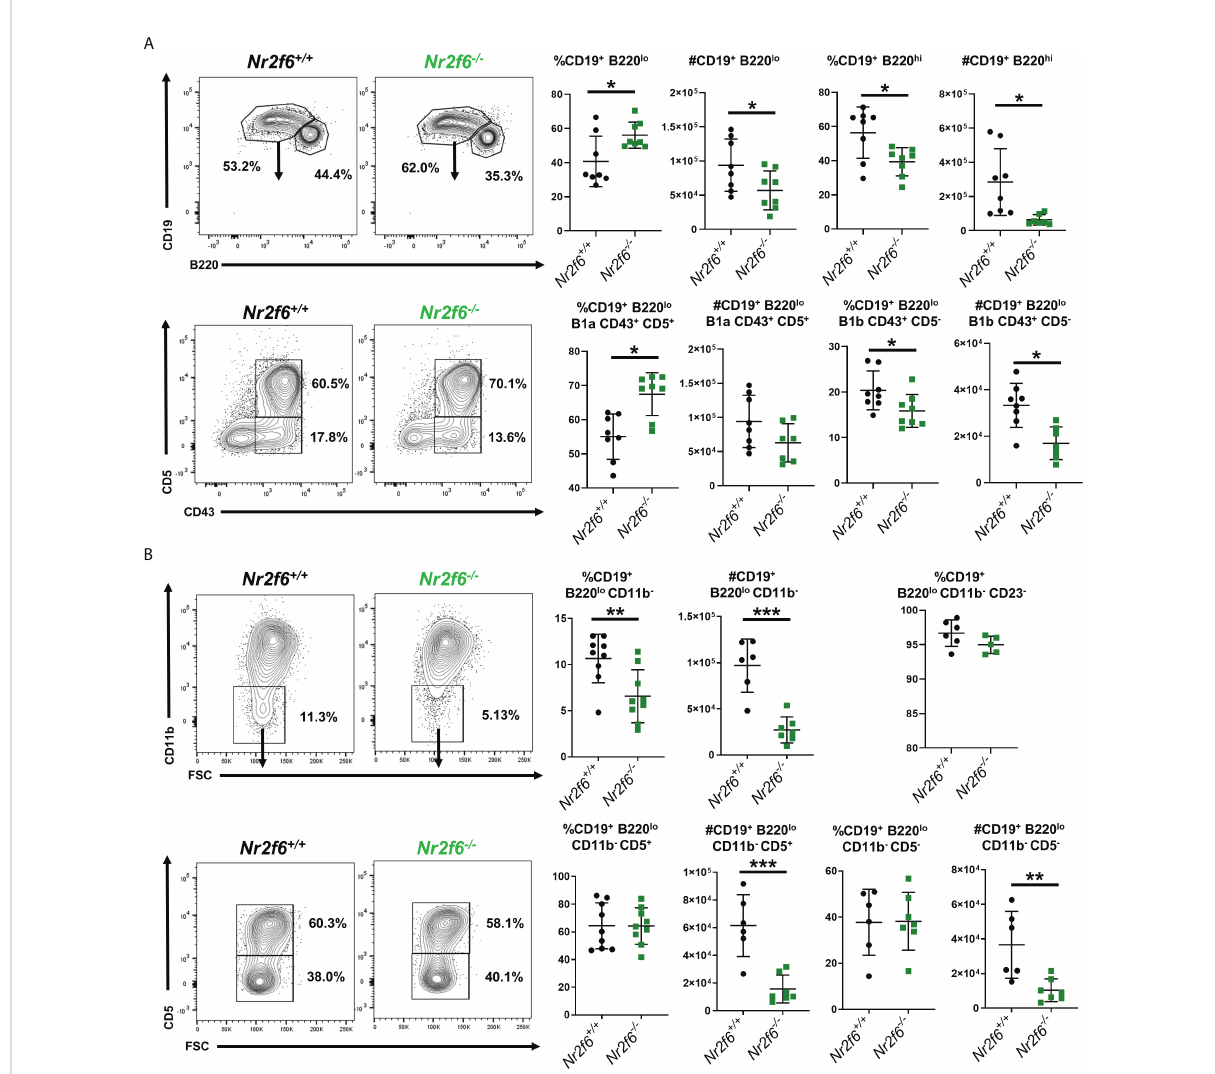
FIGURE 2 Further de fi nition of B1 and B2 cells in the peritoneum of Nr2f6 -/- mice. (A) Total peritoneal B1 cells (CD19 + B220 lo ) and B2 (CD19 + B220 hi ) were investigated by fl ow cytometry, and representative FACS plots are shown. A summary of the frequency and total counts for total B1 cells are shown on the right. B1a and B1b cells were further de fi ned from the CD19 + B220 lo population using CD43 and CD5, a representative FACS plot as well as frequency and counts from all mice investigated are shown on the right (lower row). (B) Characterization of CD11b - cells within the total CD19 + B220 lo population, representative FACS plots are shown as well as a summary of all mice investigated. Frequency and total cell counts of CD19 + B220 lo CD11b - are shown in the upper row, staining for CD5 + cells are shown in the lower row. The frequency of CD23 - cells is also shown from the CD19 + B220 lo gate (upper right panel). Each data point represents an individual mouse, data shown are from at least two individual experiments with at least two mice of each genotype per experiment. Statistical signi fi cance was determined using a two-tailed student t-test signi fi cant p-values are displayed as *<0.05, **<0.01 and